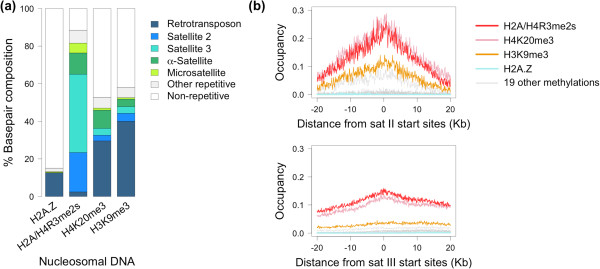
Relationship between stable nucleosomes containing histone modifications and satellite II and III DNA sequences. (a) The percentage contributions of types of repetitive elements to the total DNA sequence bound to nucleosomes containing the indicated histone modification. (b) The fraction of start site -aligned satellite II (upper) or III (lower) DNA sequences occupied by stable nucleosomes containing the indicated histone modification.